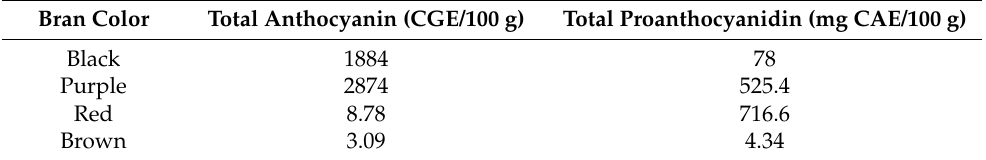
Table 1. The concentration of anthocyanins and proanthocyanins in different types of pigmented rice. Bran Color Total Anthocyanin (CGE/100 g) Black